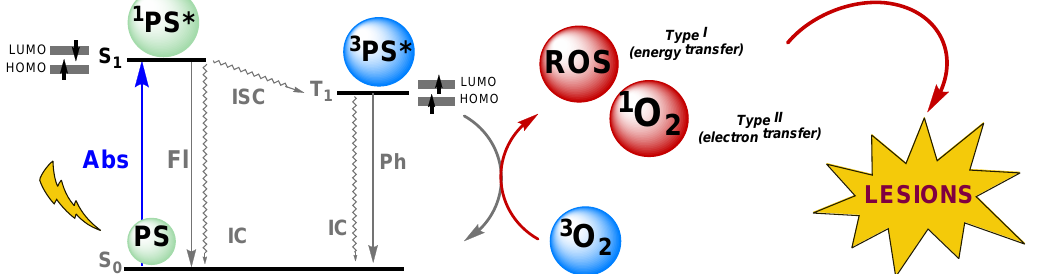
Figure 19. Verteporfin as a racemic mixture of two regioisomers.